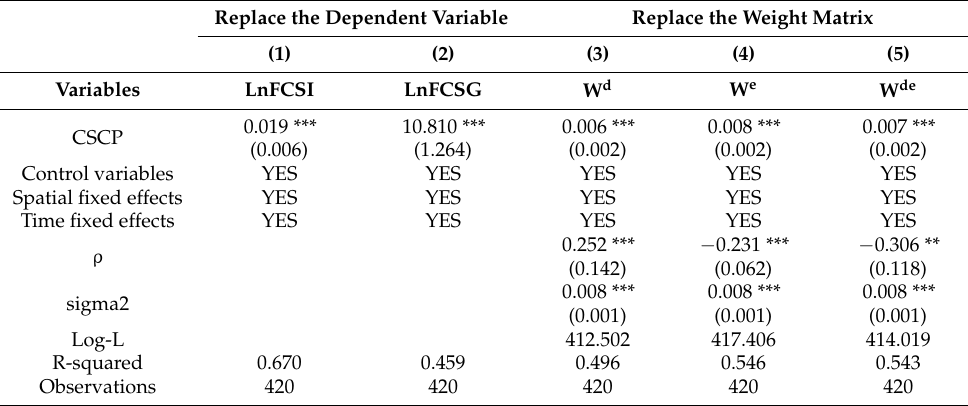
Table 6. The results of the robustness